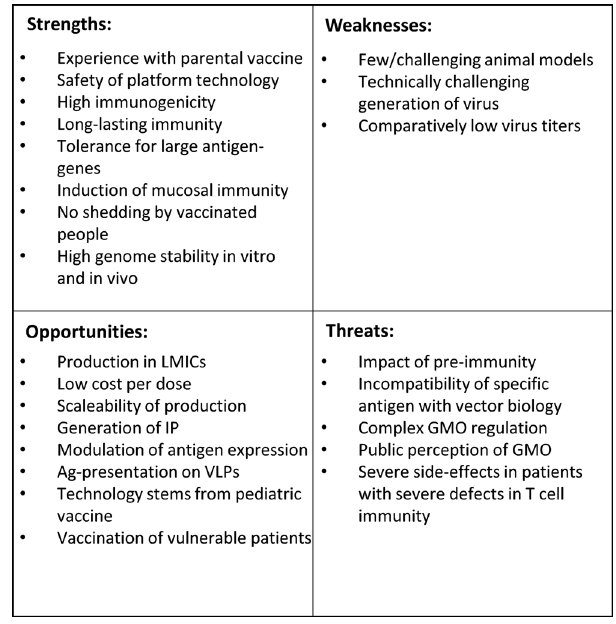
Fig. 3 SWOT analysis of live-attenuated MeV as vaccine platform technology. Depicted are strength, weaknesses, opportunities and threats of the use of live-attenuated recombinant MeV as platform technology to generate vaccines against other pathogens. LMICs low- and middle-income countries, IP intellectual property, Ag antigen, VLPs virus-like particles, GMO genetically modi fi ed